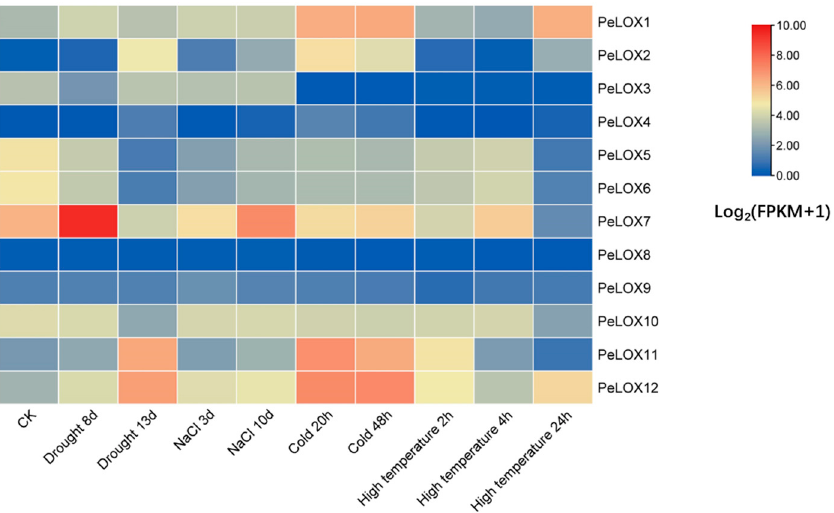
Figure 6. Heatmap of relative expression of PeLOX genes responding to drought, salt, cold, and high temperature via RNA-Seq. Blue indicates a low expression level and red indicates a high expression level.